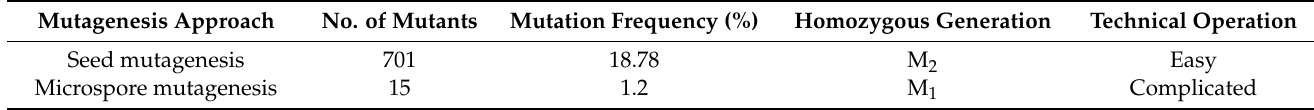
Table 5. Comparison of two mutagenesis approaches.